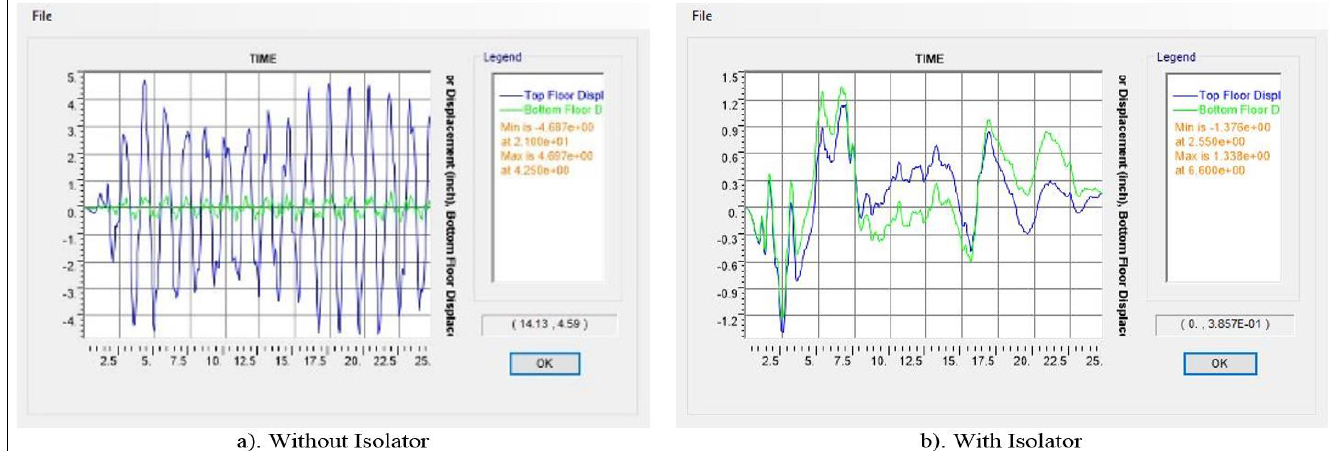
Figure 12: Top and bottom displacement vs time curve (25 sec).